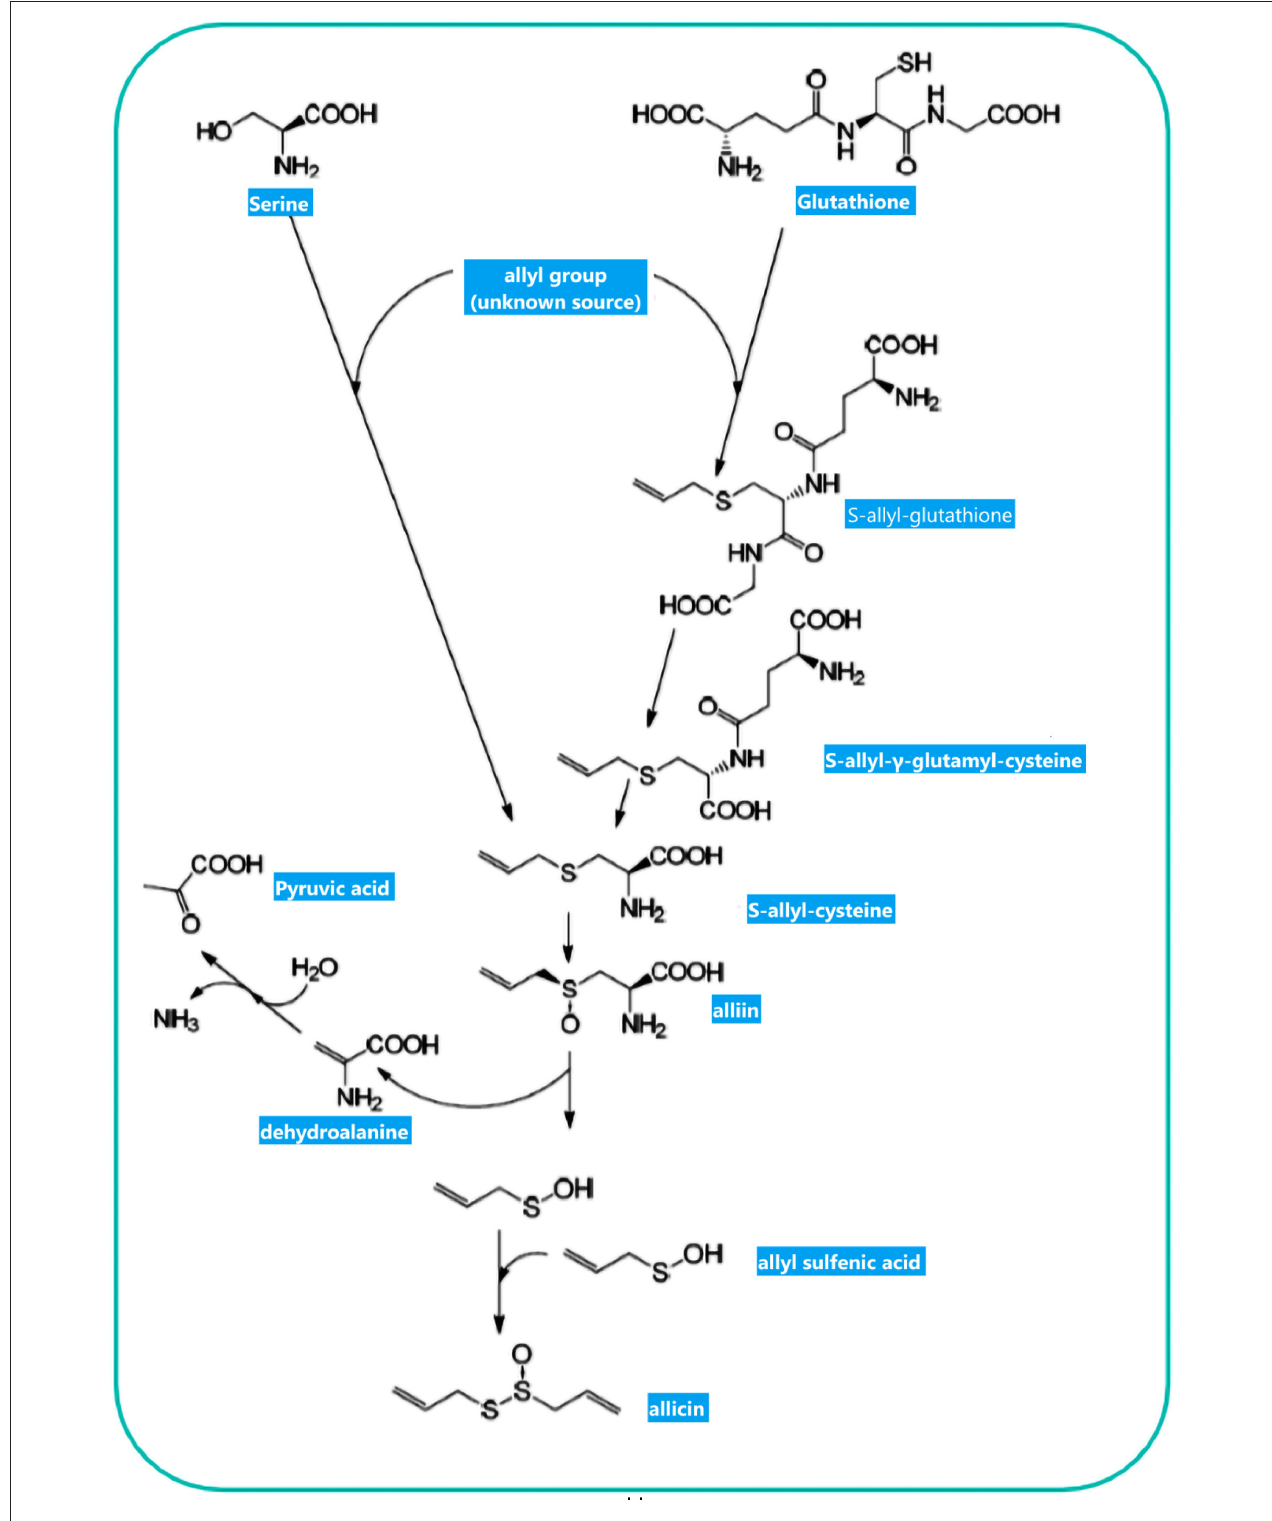
FIGURE 2 | Allicin biosynthesis: Two biosynthetic routes result in S-allylcysteine. The observation of 14C-labeled S-allylcysteine following feeding plants with 14C-labeled serine and applying several alkyl mercaptans led Granroth to posit that serine is one potential substrate for S-allylcysteine biosynthesis. Another pathway resulted from GSH to S-allylcysteine. The allyl-group source has yet to be determined. S-allylcysteine, after oxidization, is converted to alliin as an “inactive” precursor of allicin. Enzymatic hydrolysis of alliin produces allyl sulfenic acid, which can be condensed spontaneously to allicin. This figure adapted from Borlinghaus et al. (24).